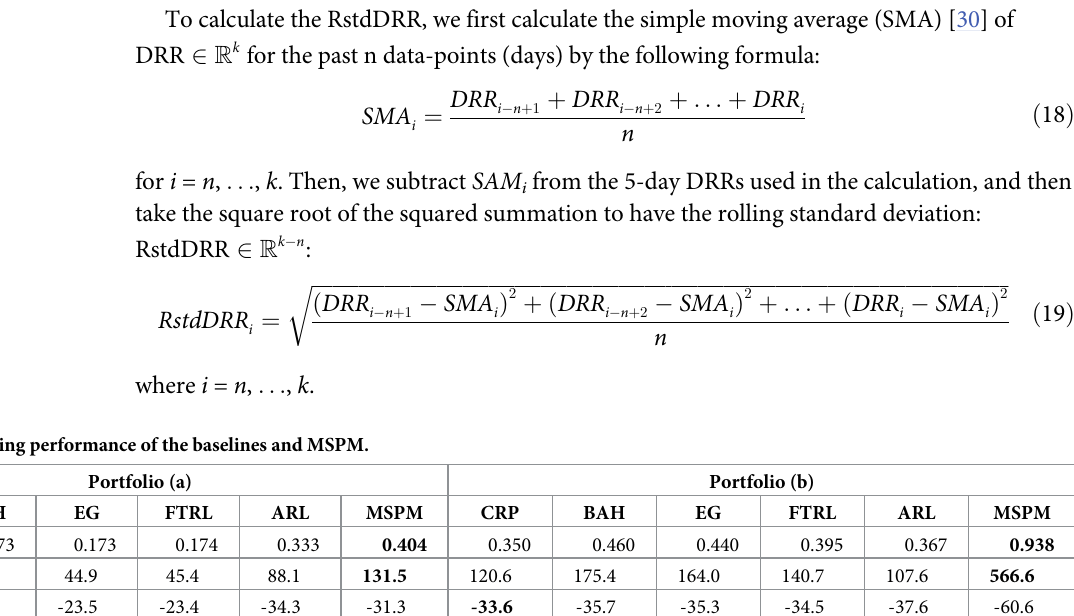
and compare the general stability of DRR between MSPM and the state-of-the-art RL-based method: ARL. For this purpose, we first calculate DRR’s 5-day rolling standard deviation (RstdDRR) as the proxy of the stability of DRR. Higher RstdDRR indicates lower stability of DRR. To calculate the RstdDRR, we first calculate the simple moving average (SMA) [30] of DRR 2 R k for the past n data-points (days) by the following formula: